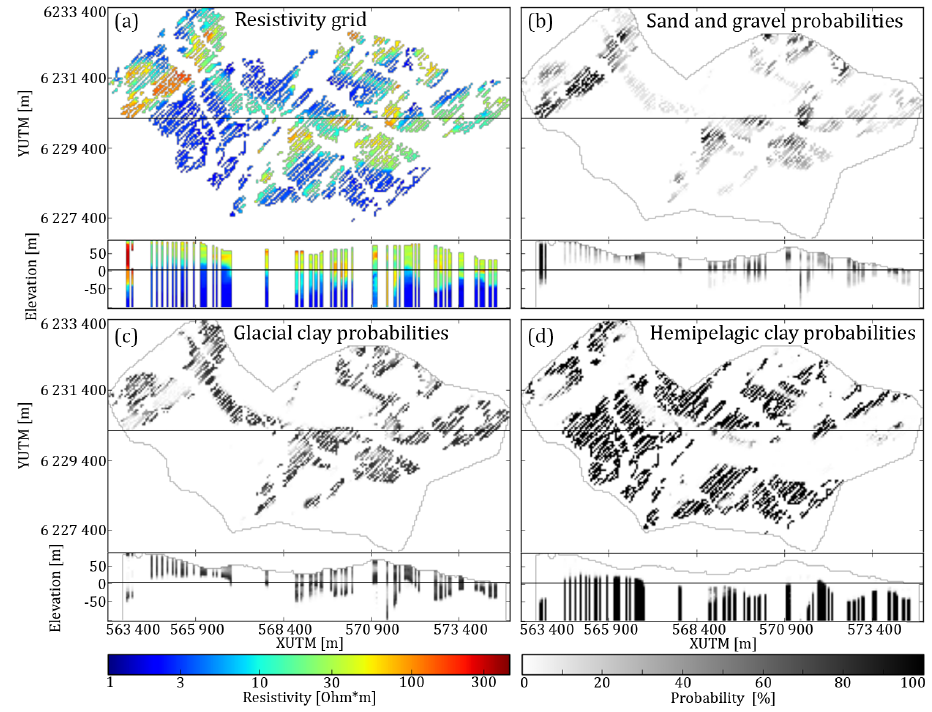
Figure 6. A presentation of the incomplete resistivity grid. Each grid is portrayed as a horizontal slice at 20mb.s.l. and a vertical cross section intersecting at YUTM 6230100m. (a) shows the resistivity grid which is translated into three probability grids using the resistivity– hydrostratigraphic relationship histograms (Fig. 1b). Grid cells without SkyTEM soundings are not assigned a probability value. (b–d) show the sand and gravel, glacial clay, and hemipelagic clay probability values,